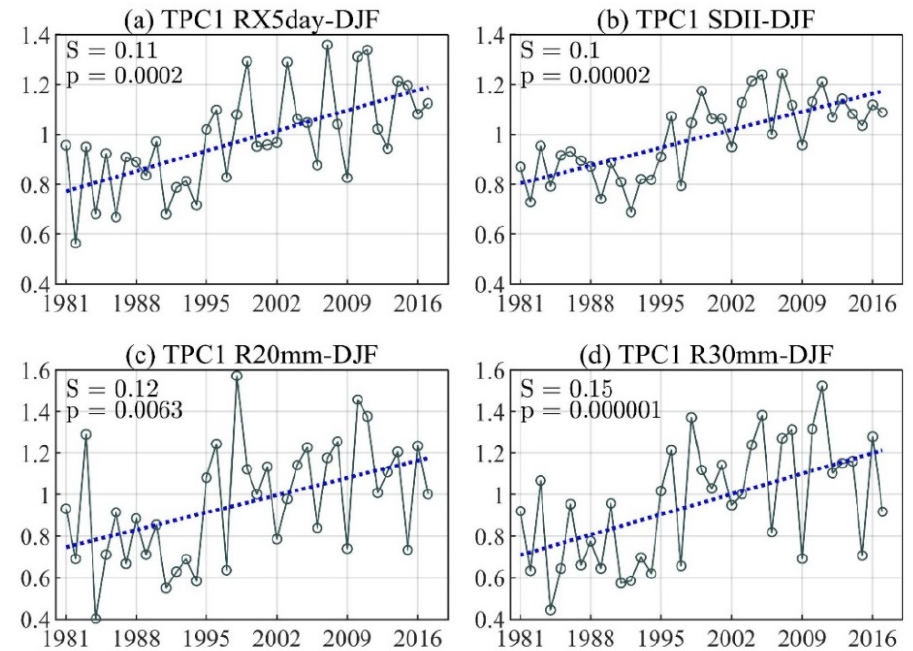
Figure 5. The linear trend of the principal component time series for the first TEOF mode of ( a ) Max 5-day precipitation amount (RX5day), ( b ) Simple daily intensity index (SDII), ( c ) Number of days with precipitations above R20mm (R20mm), and ( d ) Number of days with precipitations above R30mm (R30mm) during December–February (DJF) season.